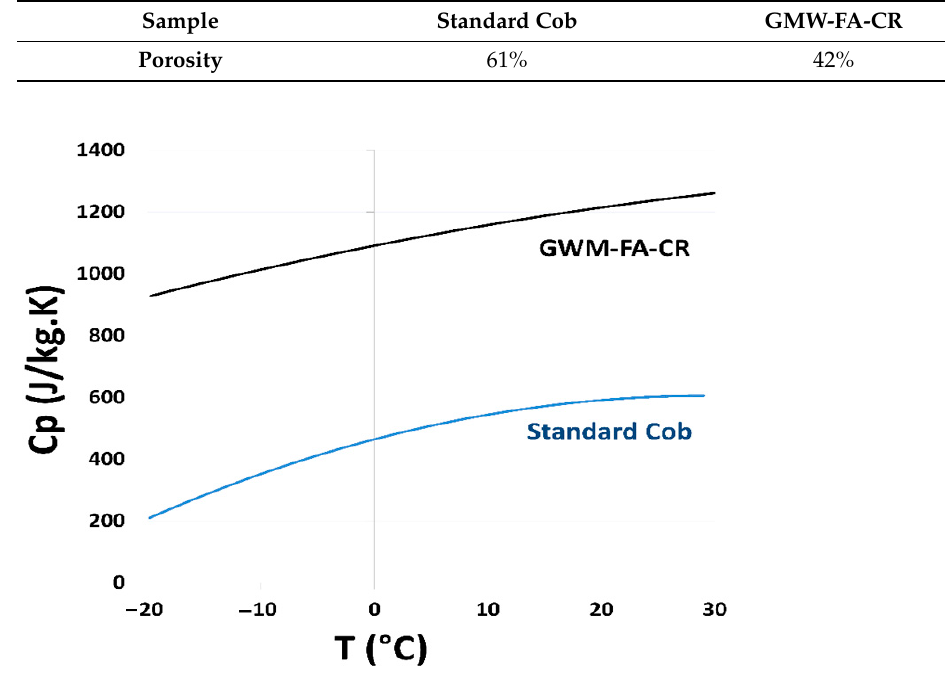
Figure 9. The variation in the specific heat capacity of the GWM-FA-CR mix and a standard cob material between − 20 °C and 30